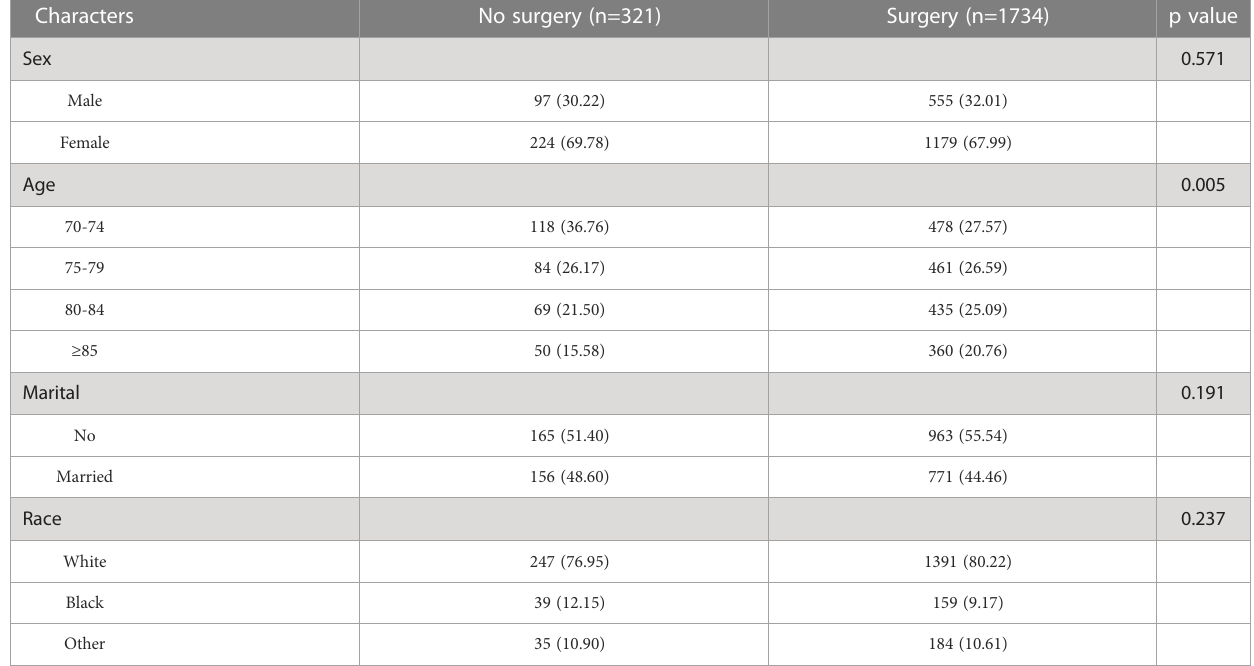
TABLE 1 Clinical characteristics of elderly patients with GBC before propensity score matching.